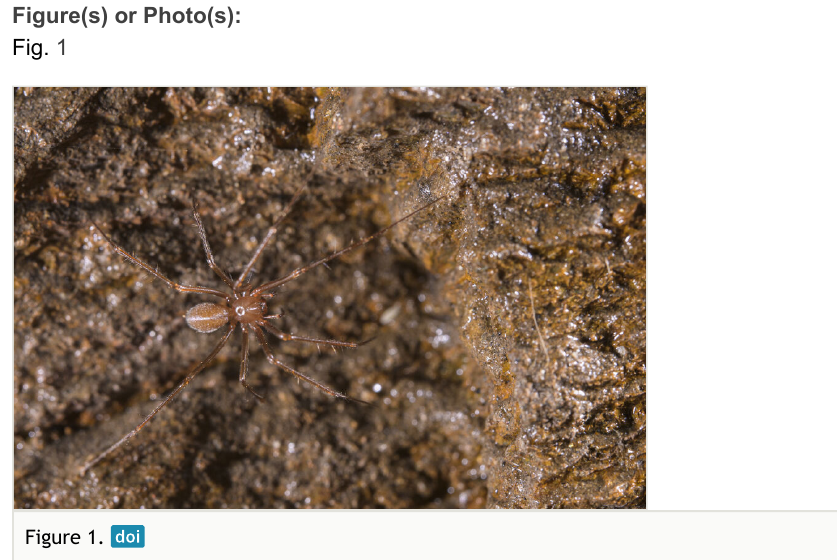
Figure(s) or Photo(s):